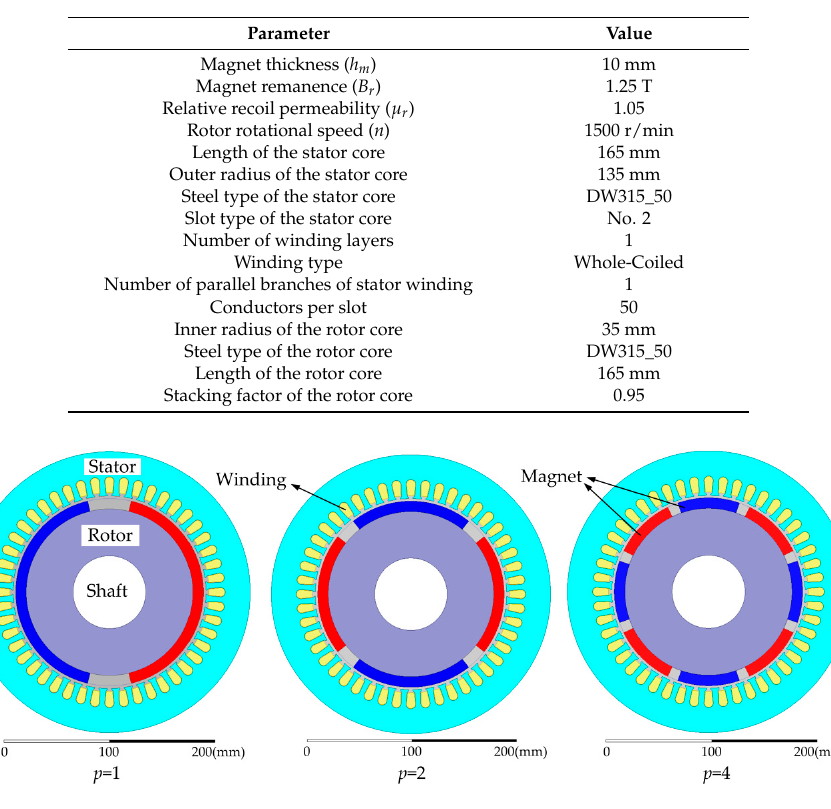
Figure 2. Models of PMSM for different pole-pair numbers.